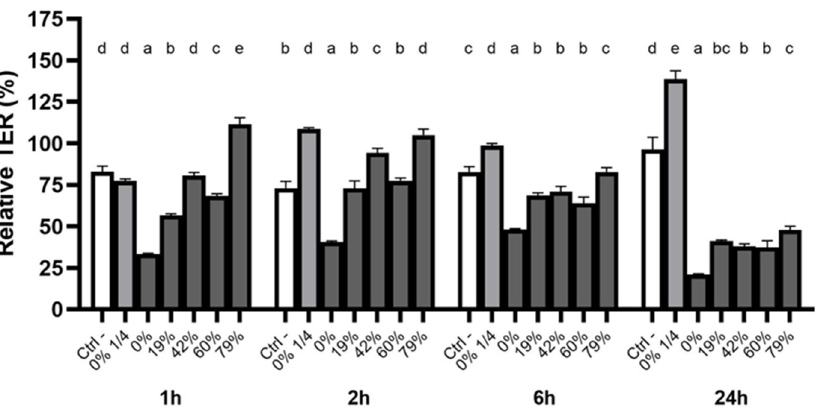
Figure 4. Time-dependent relative TER measurements of a B11 keratinocyte monolayer exposed (5 min) to raw or deacidified (0, 19, 42, 60, and 79%) cranberry juice. The basal TER of each well was measured before the exposure to cranberry juice (t 0 ). The results are expressed as means ± SD of % of TER at t 0 ( n = 3 from a representative experiment). Columns with different letters are significantly different from one another (Two-way ANOVA, Bonferroni test, p < 0.01). Ctrl: antibiotic-free K-SFM.